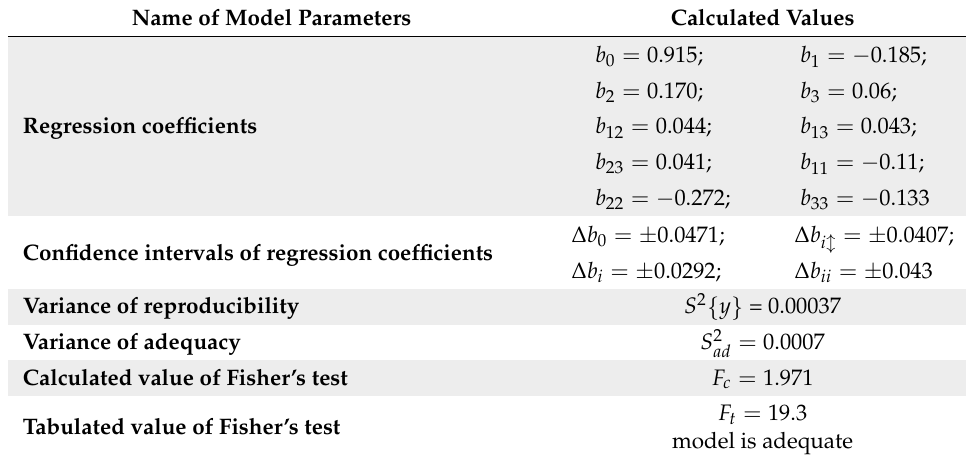
Table 3. Parameters of the mathematical